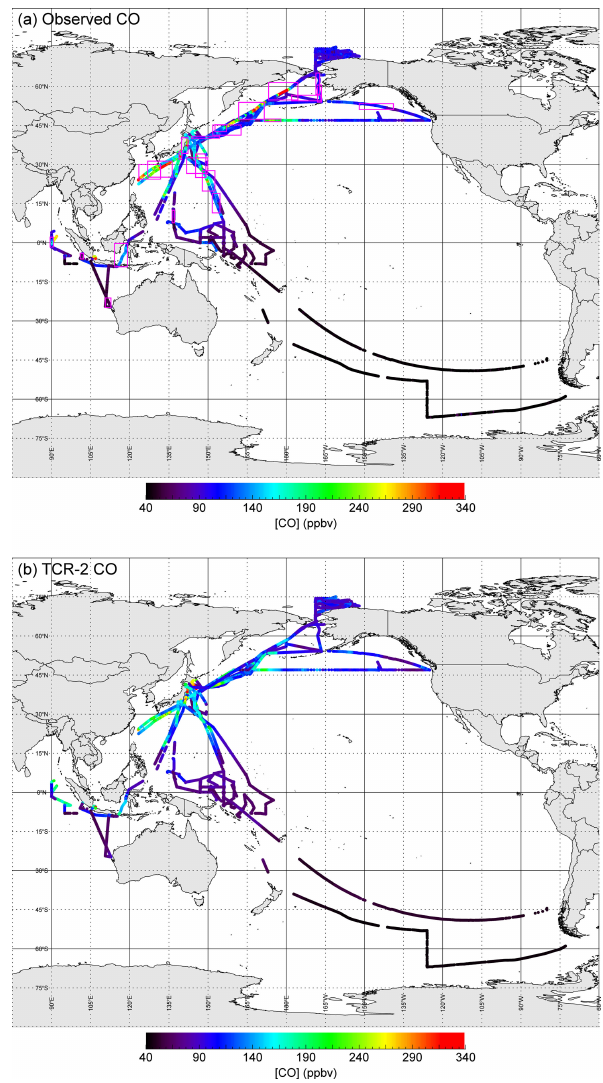
Figure 2. Geographical distributions of (a) observed CO mixing ra- tios and (b) those from TCR-2. In (a) magenta boxes indicate 23 regions where (cid:49) O 3 /(cid:49) CO ratios were analyzed (see Fig. 8 and Ta- ble 2).